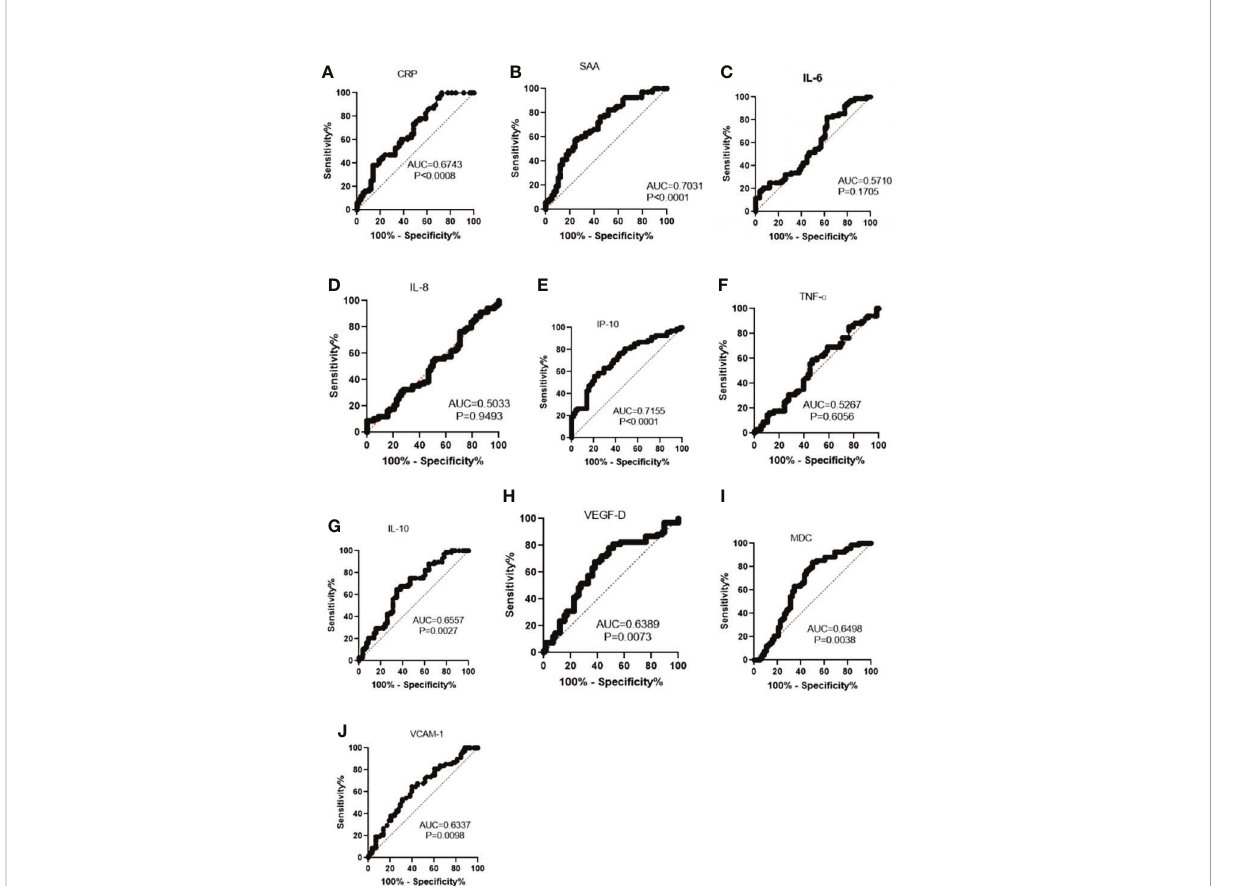
FIGURE 2 Receiver operating characteristics curve of indicators between mild/moderate and severe COVID-19 for the prediction of severity. (A) CRP, C- reactive protein. (B) SAA, serum amyloid A (C) IL-6, interleukin 6. (D) IL-8, interleukin 8. (E) IP-10, interferon- g -inducible protein-10. (F) TNF- a , tumor necrosis- a . (G) IL-10, interleukin-10. (H) VEGF-D, vascular endothelial growth factor-D. (I) MDC, macrophage-derived chemokine (MDC). (J) VCAM-1, vascular cell adhesion protein